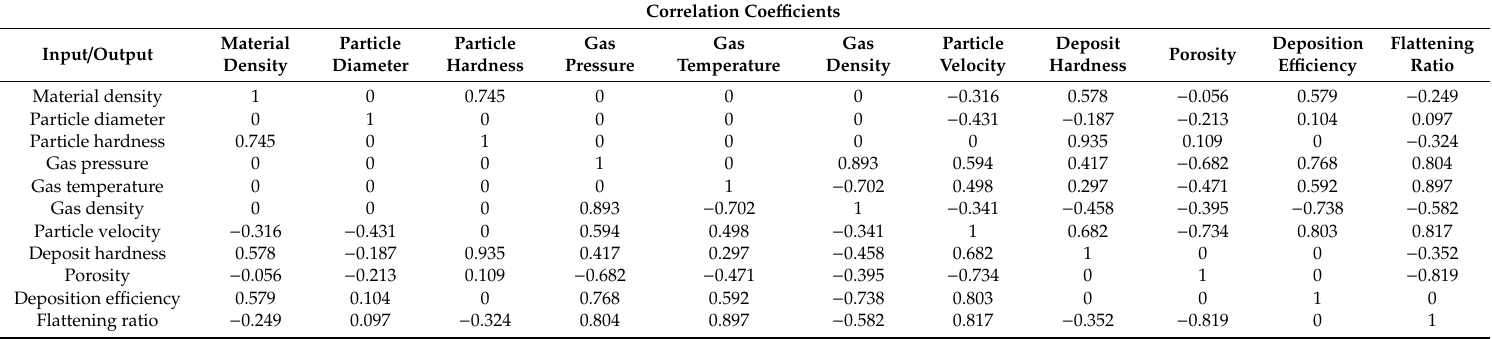
Table 3. Correlation behavior among the di ff erent input / output employed in the present study.